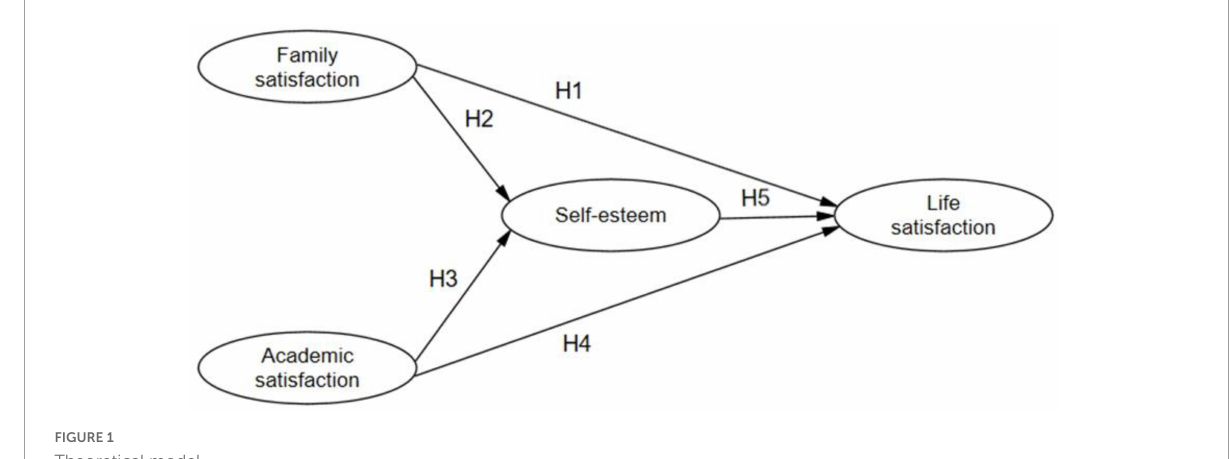
FIGURE1 Theoretical